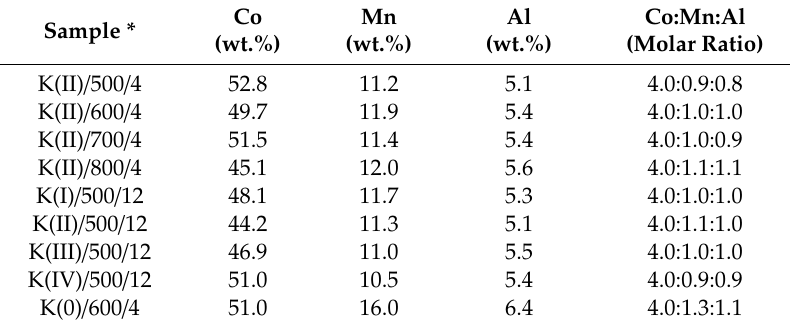
Table 1. Physicochemical properties of selected prepared catalysts.